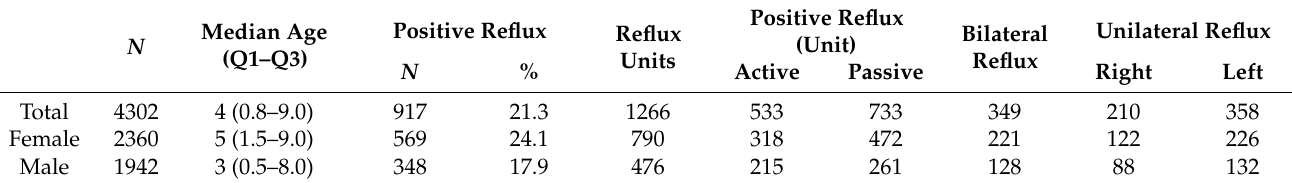
Table 1. Characteristics of examined children.